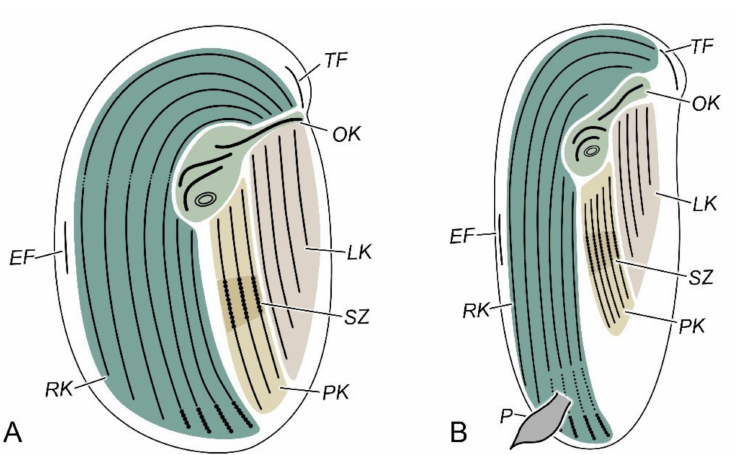
Figure 1. Schematic ciliary patterns of cyrtophorian ciliates. ( A ) Order Chlamydodontida. ( B ) Order Dysteriida. Abbreviations: EF—equatorial fragment; LK—left kineties; OK—oral kineties; P—podite; PK—postoral kineties; RK—right kineties; SZ—stomatogenetic zone; and TF—terminal